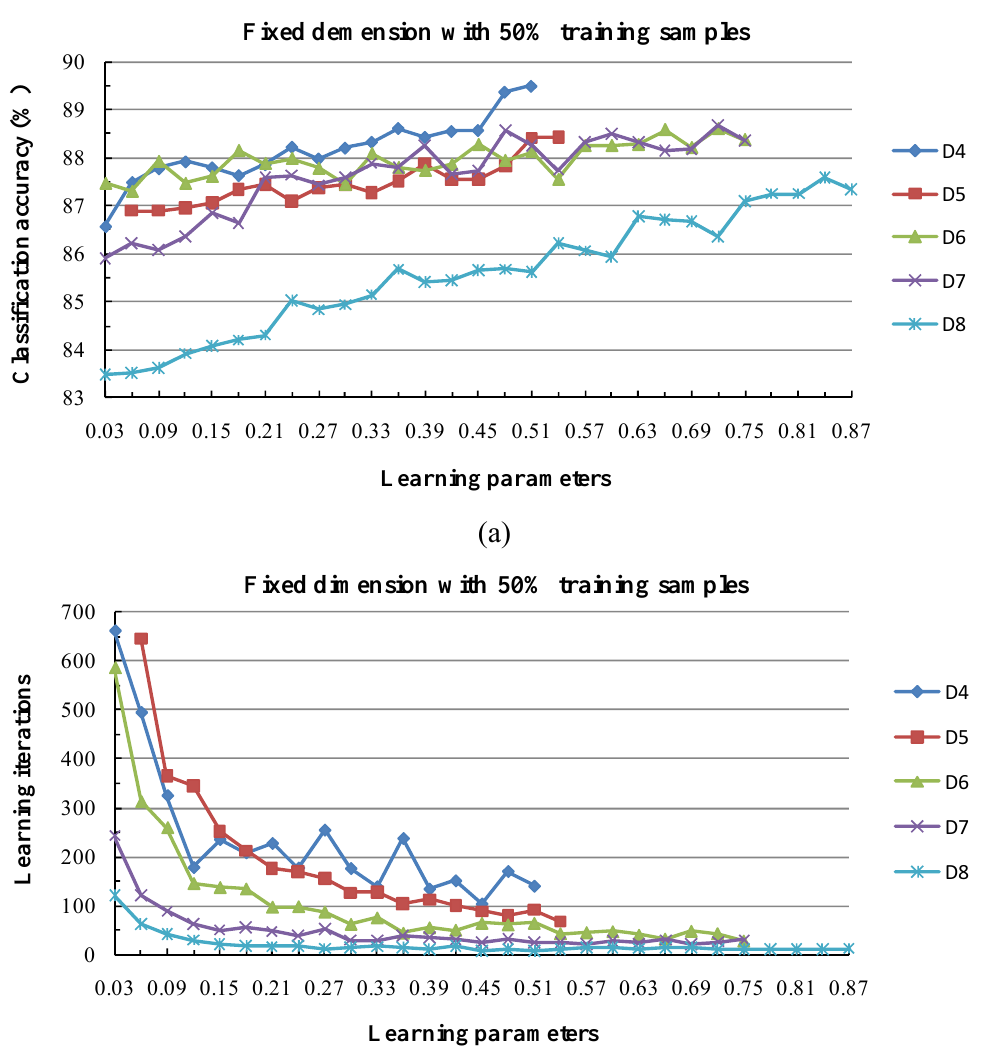
Figure 9. Behavior of the algorithm with low sample sizes. (a) Classification accuracy and (b) maximum training iterations for various subspace dimensions and learning parameters after reducing the number of training samples by 50%. The maximum classification accuracy value was reached at 89.50% in D4 for the learning parameter 0.51; the corresponding maximum training iteration was 141.